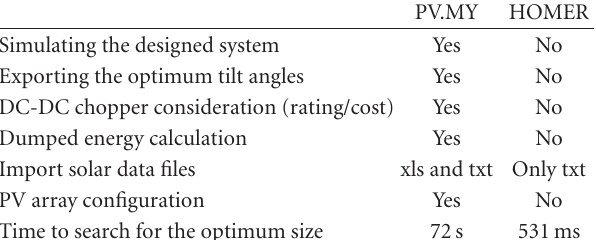
Table 2: Comparison with